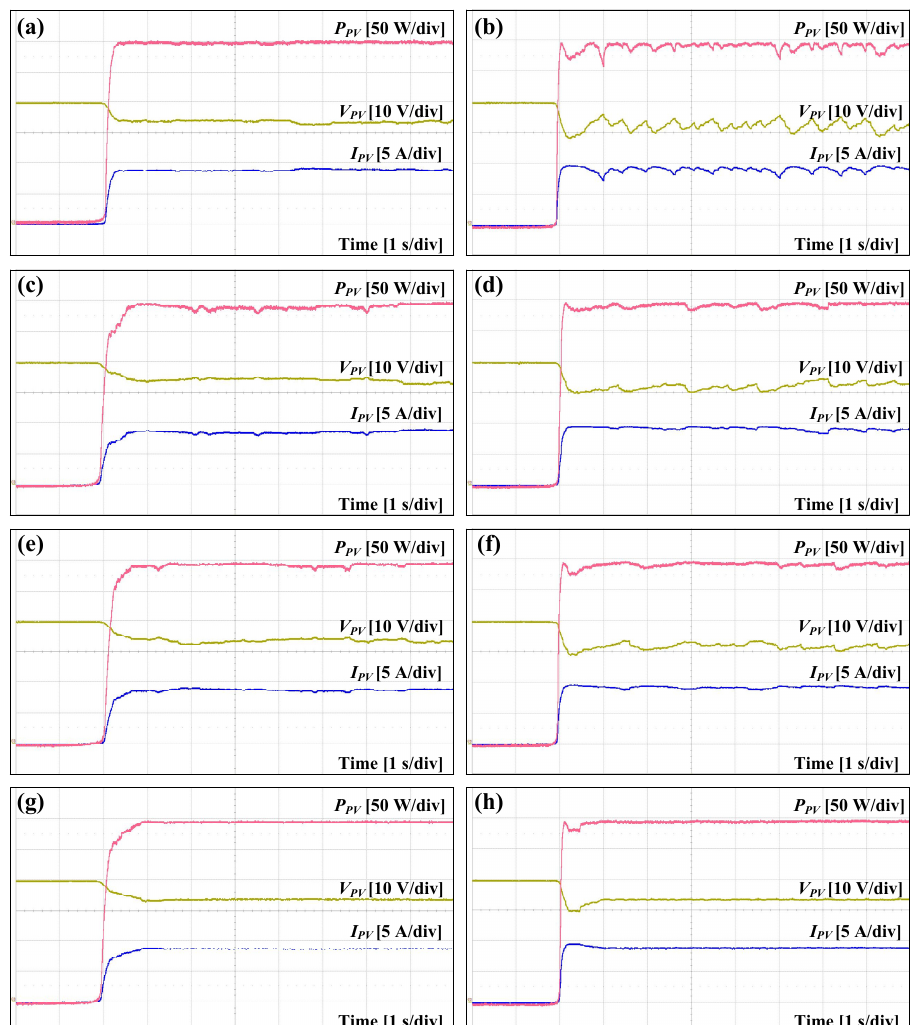
Figure 14. Voltage ( V PV ), current ( I PV ), and power ( P PV ) waveforms of the PV module measured using the basic P&O algorithm with ( a ) small fixed step size or ( b ) large fixed step size, using the adaptive P&O algorithm with ( c ) low k 1 ( = 0.00002) or ( d ) high k 1 ( = 0.0001), using the adaptive INC algorithm with ( e ) low k 1 ( = 0.00002) or ( f ) high k 1 ( = 0.0001), and using the proposed MPPT algorithm with ( g ) low k 1 ( = 0.00002) and small fixed step size or ( h ) high k 1 ( = 0.0001) and small fixed step size.